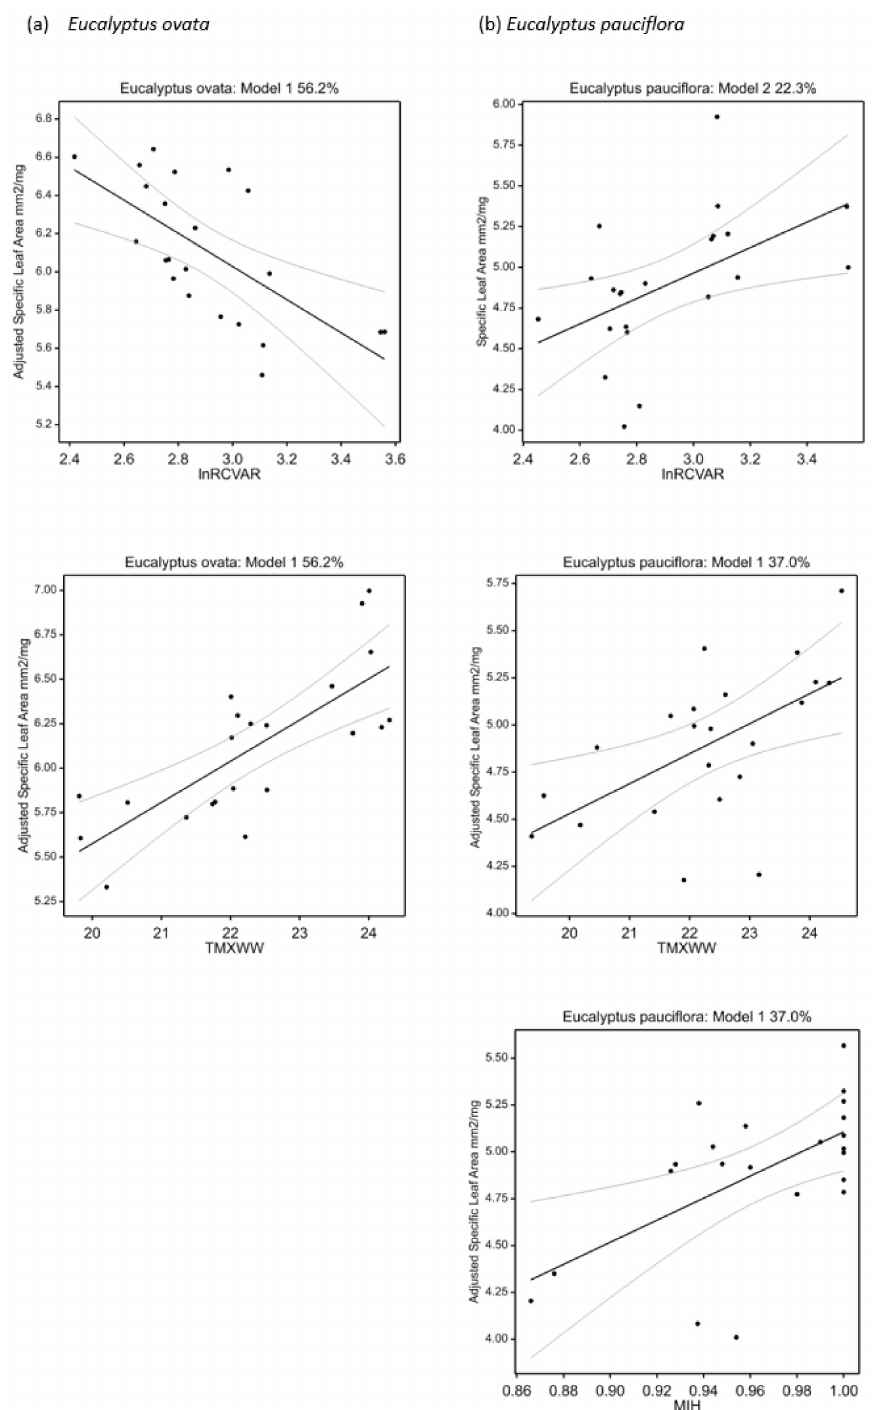
Figure 2. Partial dependency plots for selected regression models for specific leaf area: ( a ) E. ovata , and ( b ) E. pauciflora (see Table 6). The percentage of the total variance explained (R 2 ) in the response variable is provided for each full model, and the relationships of specific leaf area with each of the climate predictor variables included in each model are shown (adjusted for other predictors modelled where appropriate). The overall models and their regression parameters for the climate predictors were statistically significant at p < 0.05. The 95% confidence intervals are also